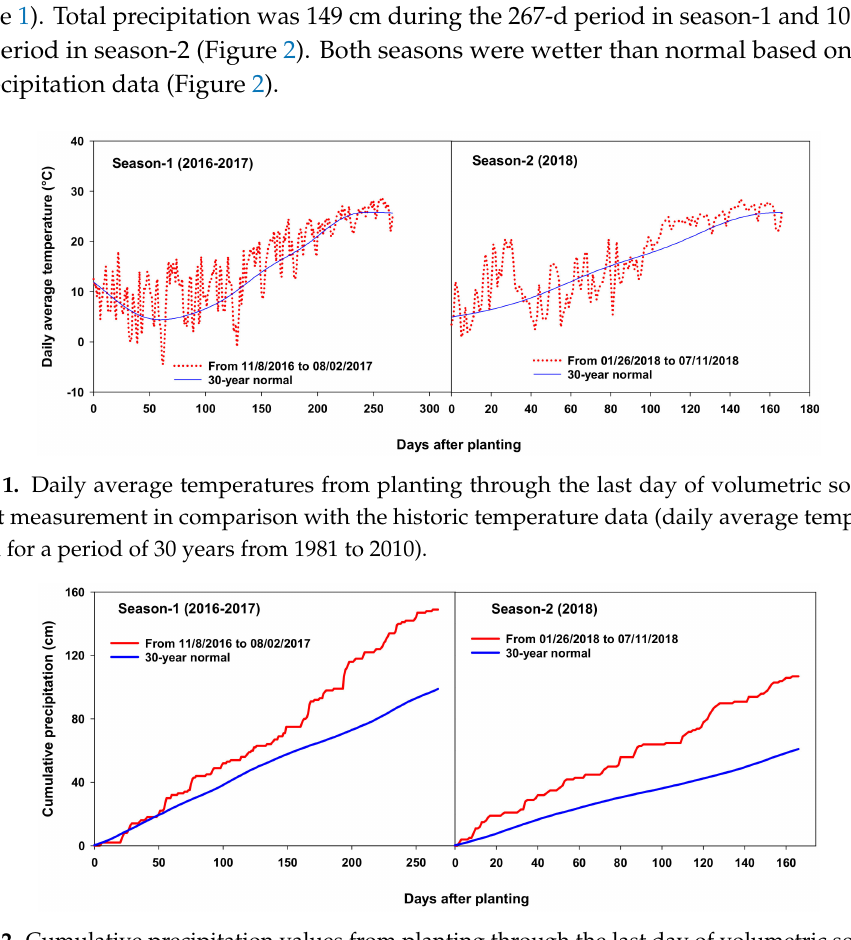
Figure 2. Cumulative precipitation values from planting through the last day of volumetric soil water content measurement in comparison with the historic precipitation data. Cumulative precipitation normals for the same 267-d period in season-1 and 166-d period in season-2 were calculated from the daily precipitation normal for a period of 30 years from 1981 to